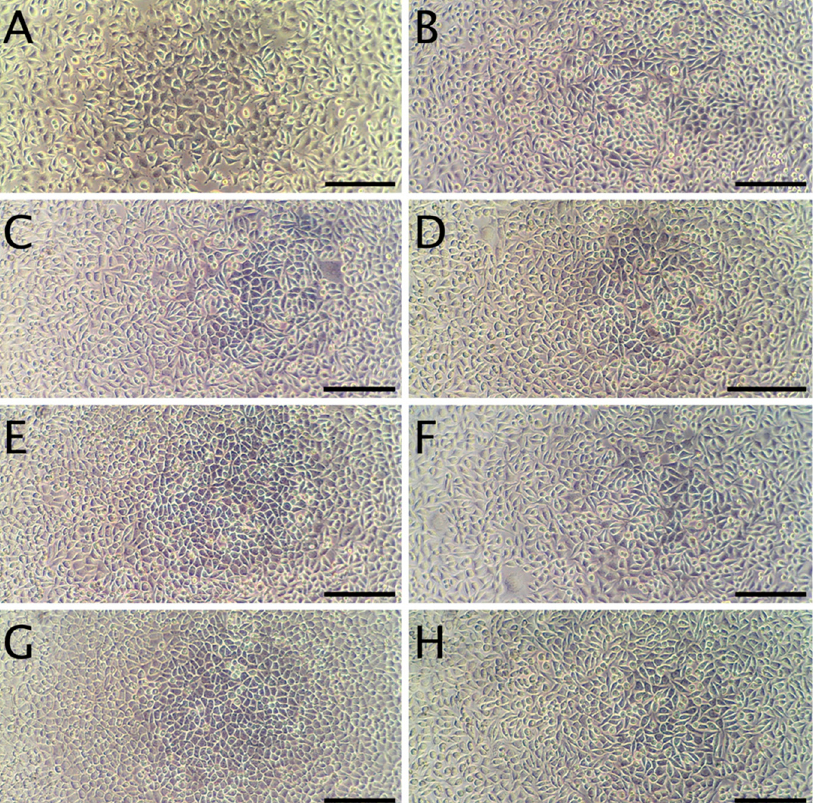
Figure 4. Representative micrographs of L929 fibroblasts. Panel ( A ): cells 24 h after seeding, but prior to the addition of extracts. Panel ( B ): Cells incubated for 24 h with the sham extract. Panels ( C , E , G ) present cells incubated with WPC extracts (WPC; WPC-0.1% and WPC-0.5%) for 24 h. Panels ( D , F , H ) present cells incubated with WPI extracts (WPI; WPI-0.1% and WPI-0.5%) for 24 h. The scale bar represents 200 μ m.